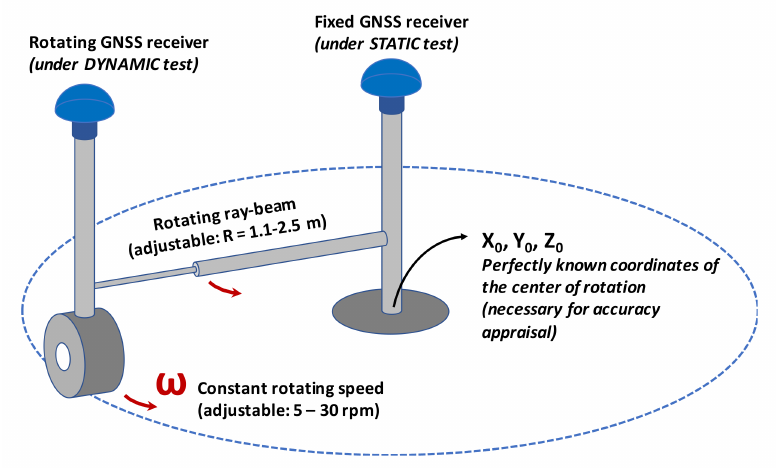
Figure 8. Scheme of a “RotoGPS” used for performing contextually both static and dynamic test on the same type of two GNSS receivers. A measure of both accuracy and precision of the receiver at hand is simultaneously achieved for the two test